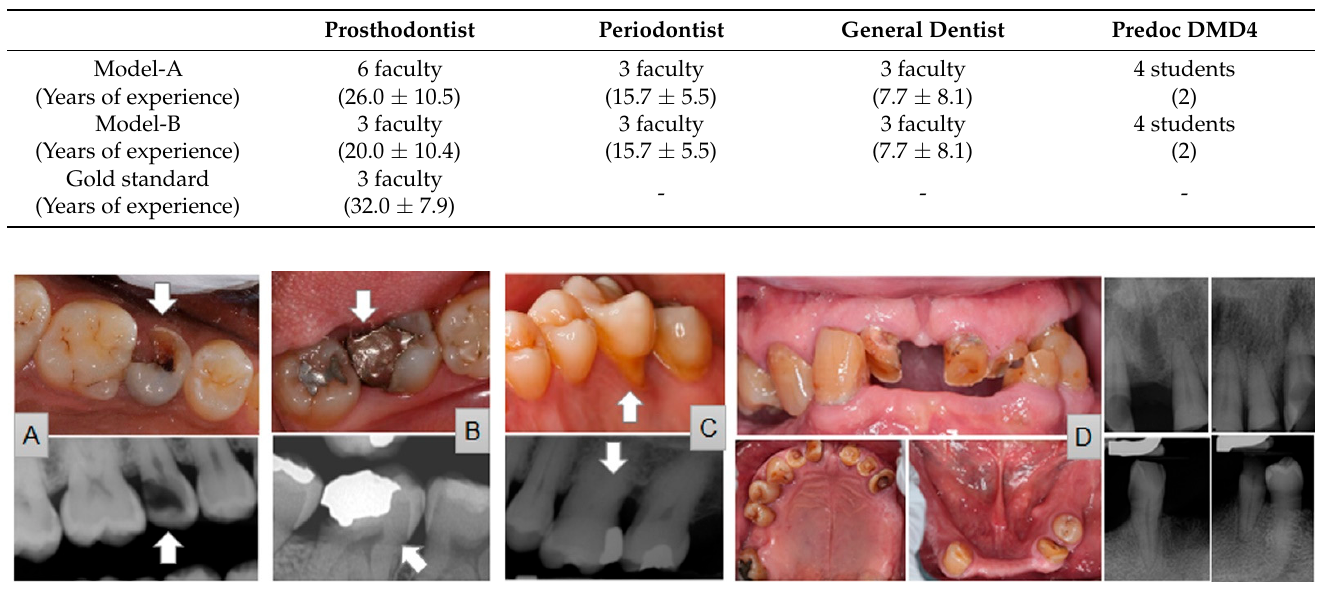
Figure 2. Samples of teeth for ranking. ( A ): #4 with extensive caries. ( B ): #31 with tooth fracture and open margin. ( C ): #14 with significant bone loss. ( D ): #7, 8, 9 10, 11 and #21 with loss of occlusion.